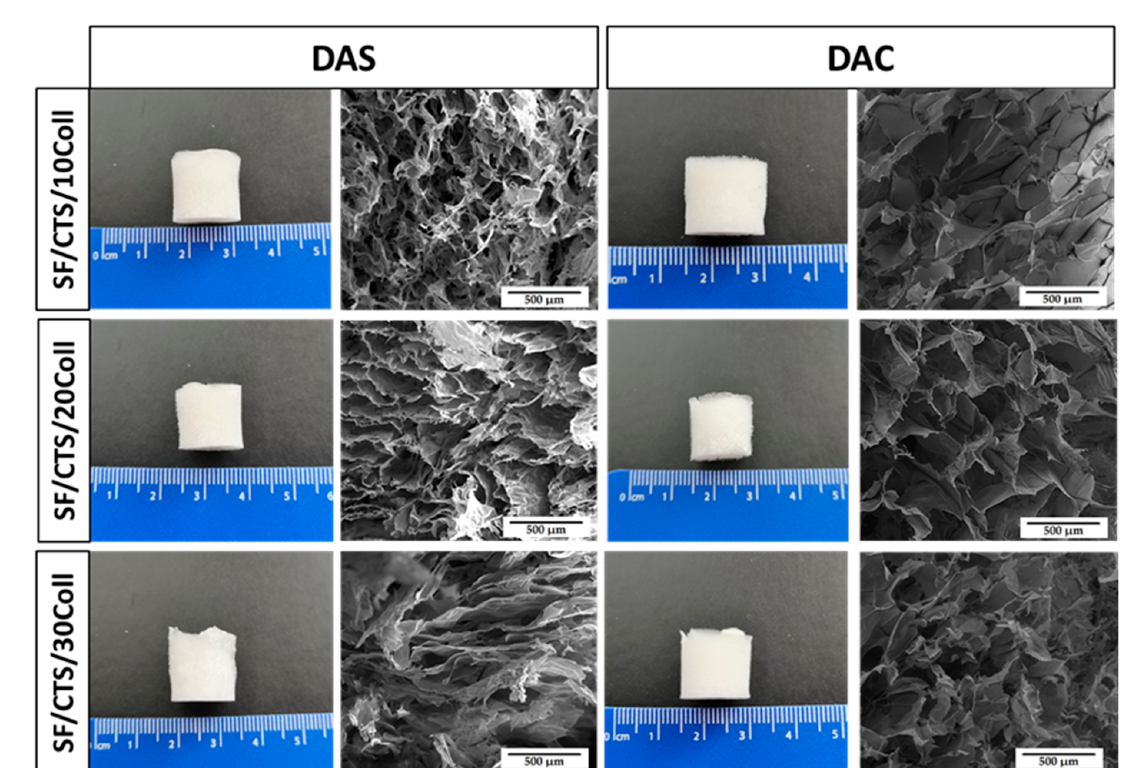
Figure 9. Macroscopic appearance and SEM micrographs of 50/50 SF/Coll scaffolds with 10, 20 and 30% addition of chitosan cross-linked with dialdehyde starch (DAS) and dialdehyde chitosan (DAC).